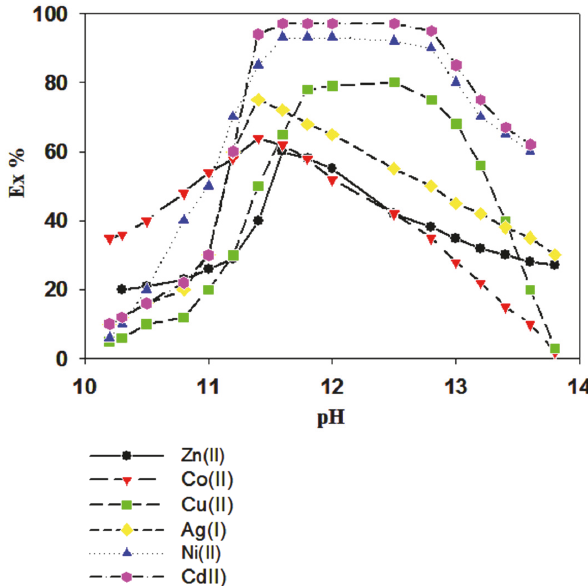
Figure 1: Extractability of all tested transition metal ions as a function of pH. Organic phase: H L = 5 × 10 −4 M; aqueous phase: 8 = ( e ) 5 × 10 −5 M; succinic acid = 0.01 M; and buffer solution: 0.01 M; MES-NaOH (pH 5.0–7.0) and 0.1 M Tris-HClO 4 (pH 7.0–9.0). [Cd 2+ ] = ( ◼ )1 × 10 −4 M, 0.2 M NaClO 4 . O/A = 1; T = 25 ∘ C. O:A represents the ratio between organic (O) and aqueous (A) volumes in the